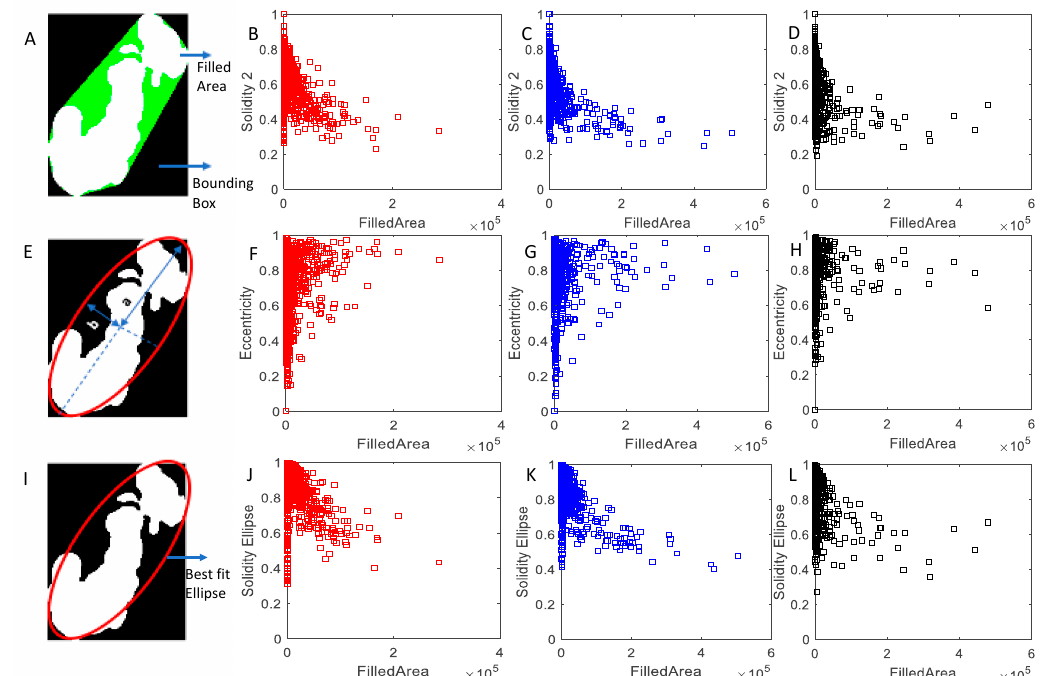
Figure 2. Morphology parameters and criteria used for identification of single particle, small and large clusters. ( A , E , I ) demonstrate the definition of Solidity 2, Eccentricity, and Solidity Ellipse, respectively. Specifically, Solidity 2 is the ratio of filled area to bounding box; Eccentricity = 1 − ( b 2 / a 2 ) , where a and b are the semi-major and semi-minor axes of the best fit ellipse respectively; Solidity ellipse is the ratio of filled area to area of the best fit ellipse. ( B – D , F – H , J – L ) represent plots of Solidity 2, Eccentricity, and Solidity Ellipse as a function of Filled Area (in pixel) of aggregates formed respectively, upon addition of 52 vol% (red squares), 55 vol% (blue squares), and 57 vol% (black squares) n -heptane. Small clusters were identified under the following criterion: Solidity 2 < 0.9 & Solidity 2 > 0.7 & Eccentricity < 0.5. Large clusters were identified under the following criterion: Eccentricity > 0.7 or Solidity_ellipse < 0.9. Single particles were identified under the following criterion: Solidity 2 < 0.9 & Solidity 2 > 0.7 & Eccentricity < 0.5 & Filled Area < 2000 (in pixel).